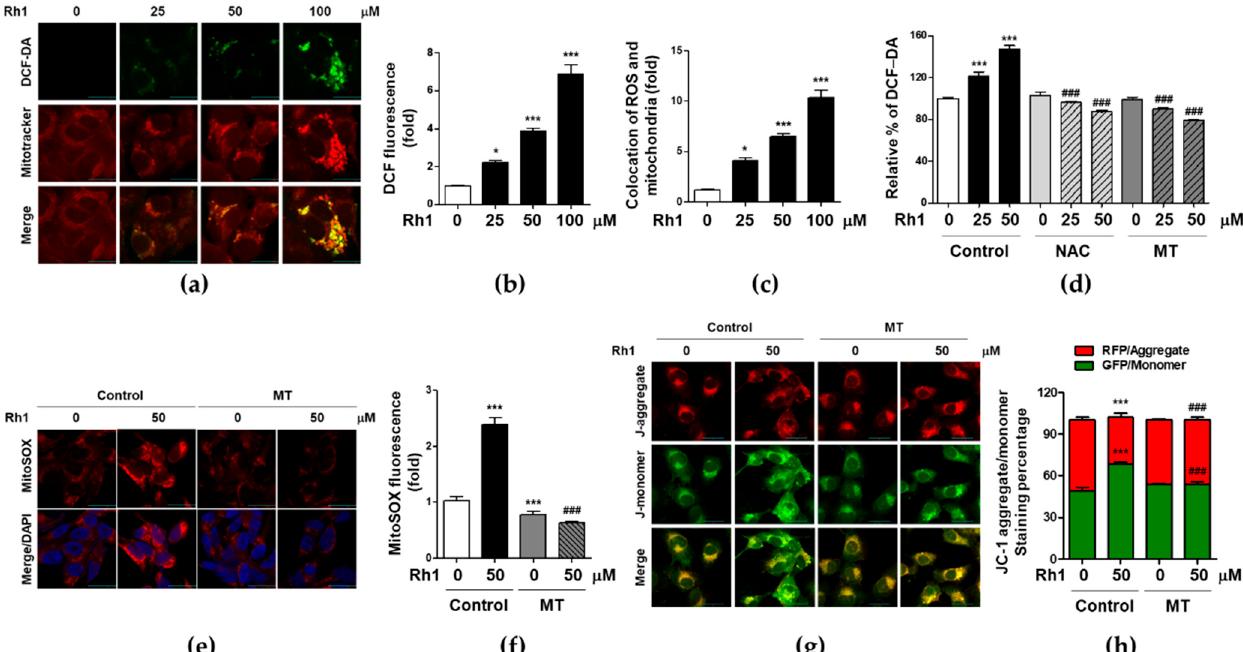
Figure 3. Rh1 induced mitochondrial dysfunction via producing mitochondrial ROS. ( a – c ) MDA-MB-231 cells were treated with the indicated doses of Rh1 for 24 h and intracellular ROS generation and morphology of mitochondria were determined by fluorescence assay. ( b – c ) The fluorescence intensity of DCF-DA ( b ) or mitotracker ( c ) was measured using image J software and indicated as fold change compared to the control (no treatment). The scale bar indicates 30 μ m. ( d ) MDA- MB-231 cells were pretreated with 5 μ M of mito-TEMPO (MT) or 10 mM NAC, followed by treatment with the indicated doses of Rh1 for 24 h and intracellular ROS generation was determined by DCF-DA assay. ( e – h ) MDA-MB-231 cells were pretreated with 5 μ M of MT for 1 h followed by treatment with 50 μ M Rh1 for 24 h. The fluorescence intensity of MitoSOX ( e , f ) or JC-1 ( g , h ) was measured using image J software and indicated as fold change compared to the control. The scale bar indicates 30 μ m. The data are presented as means ± SEM ( n = 3). * p < 0.05 or *** p < 0.001 vs control. ### p < 0.001 compared with each inhibitor alone.